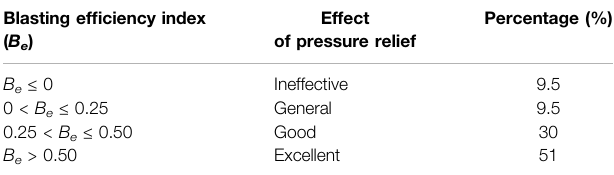
TABLE 3 | Classi fi cation system for the evaluation of B e .